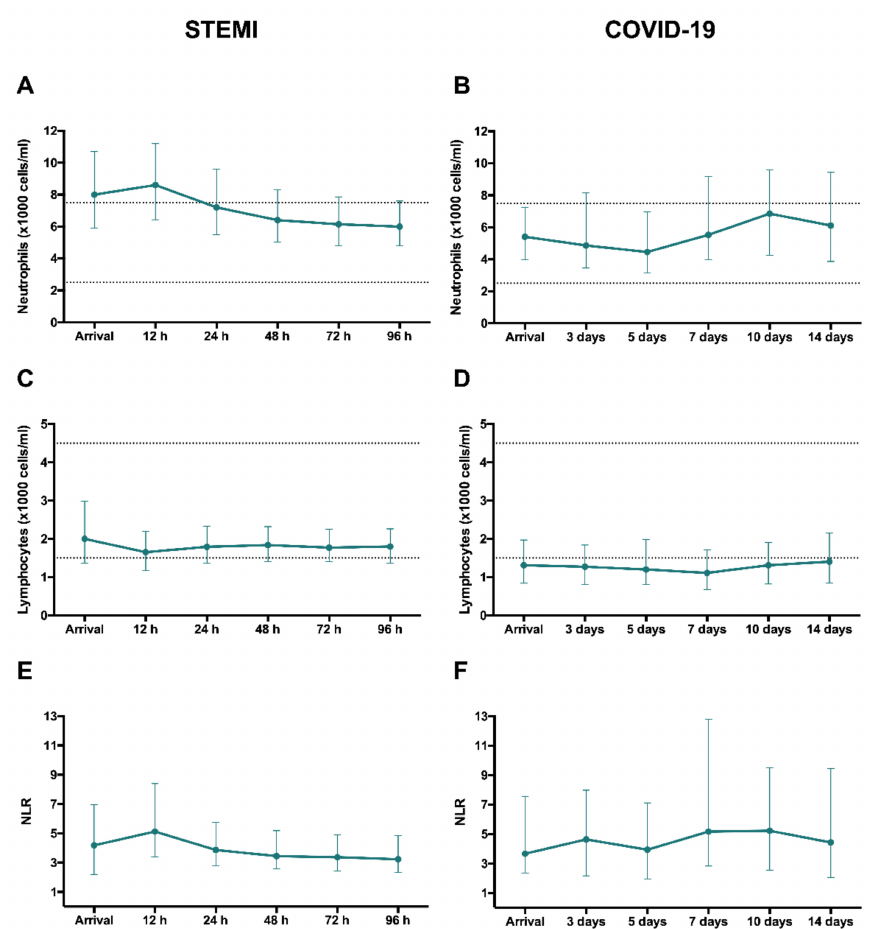
Figure 4. Evolution of neutrophil and lymphocyte counts and NLR after reperfused STEMI and COVID-19. Time course of median neutrophil and lymphocyte ( × 1000 cells / mL) counts and NLR in the entire cohort of STEMI patients ( A , C , E , respectively) and COVID-19 ( B , D , F , respectively). Data were expressed as median [quartile 25-quartile 75]. Dotted lines represent the upper and lower ranges of normality. COVID-19: coronavirus disease 2019; NLR: neutrophil-to-lymphocyte ratio; STEMI: ST-segment elevation myocardial